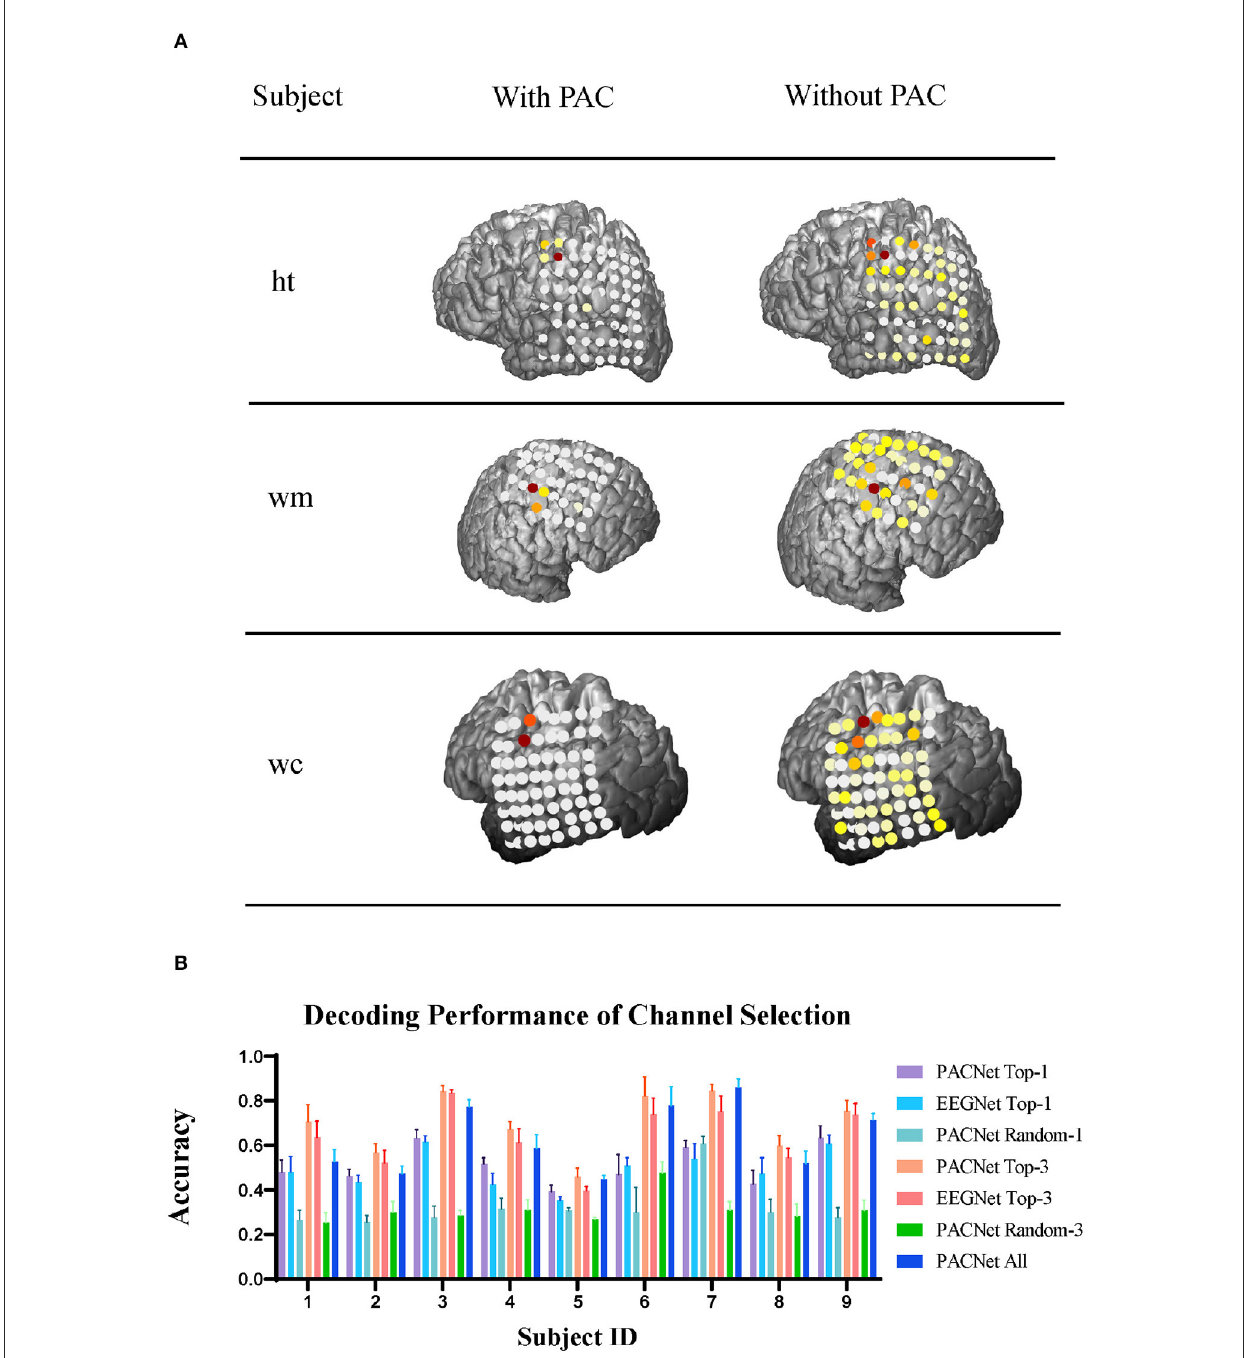
FIGURE3 Channel contribution analysis: (A) To analyze three subjects in the ECoG electrodes channel contribution of visualization in the actual network model, the image is divided into two columns, the left is the use of our filter, filter is not used on the right is, network model after the training, each channel’s contribution to the classification results of different weights are obtained. (B) Our electrode with high contribution for our elected the decoding performance tests of different